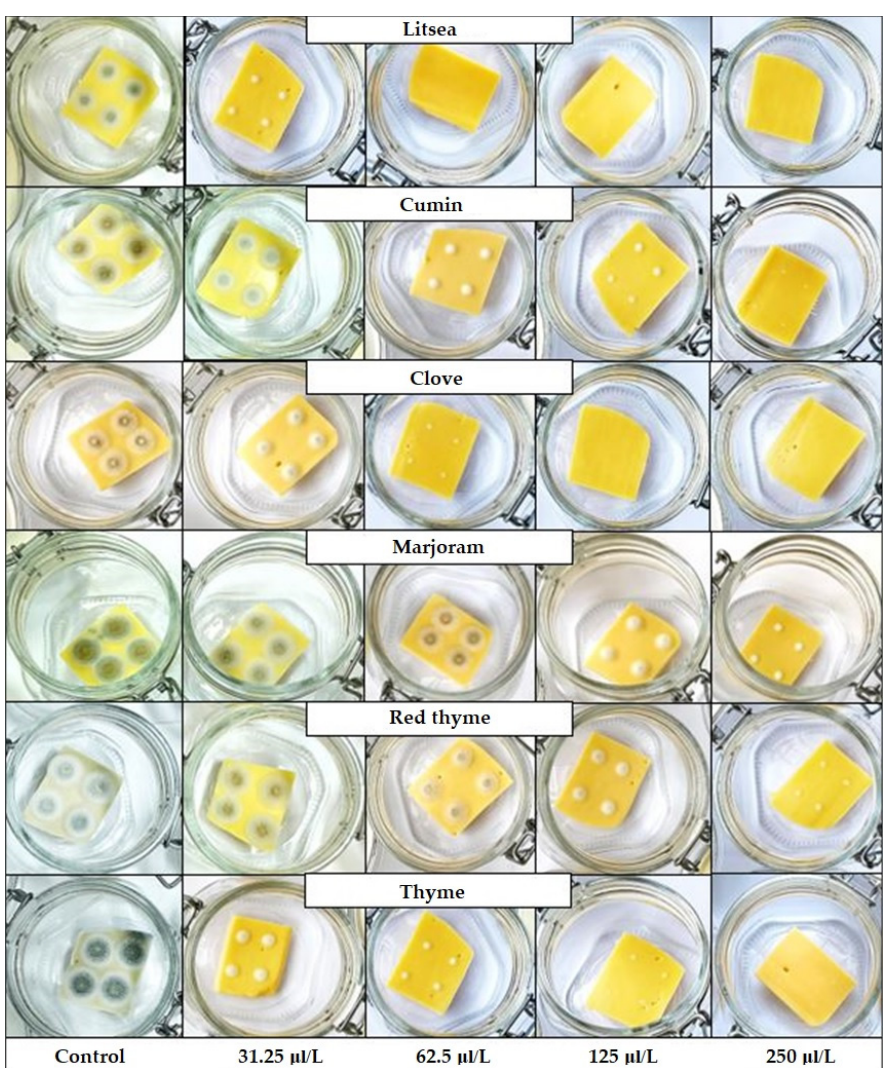
Figure 1. Tested concentrations (250–31.5 µ L/L) of effective essential oils for the growth of P. commune strain (KMi–402) on model food (cheese) on the 14th day of cultivation at a temperature of 5 ± 1 ◦ C. Cumin and marjoram EOs could represent a suitable alternative to preservatives, because cumin is commonly added to some types of cheese to improve the taste